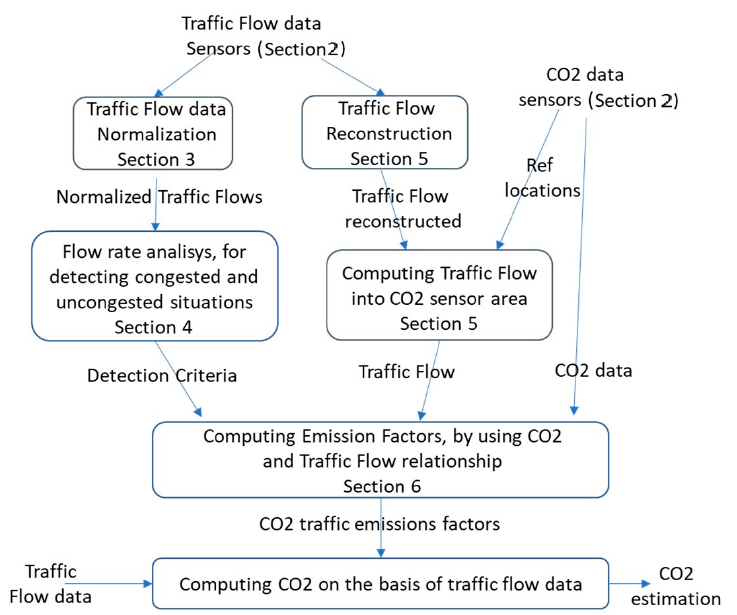
Figure 1. Data flows and solutions to pass from traffic flow to CO 2 estimation, with paper section mapping.